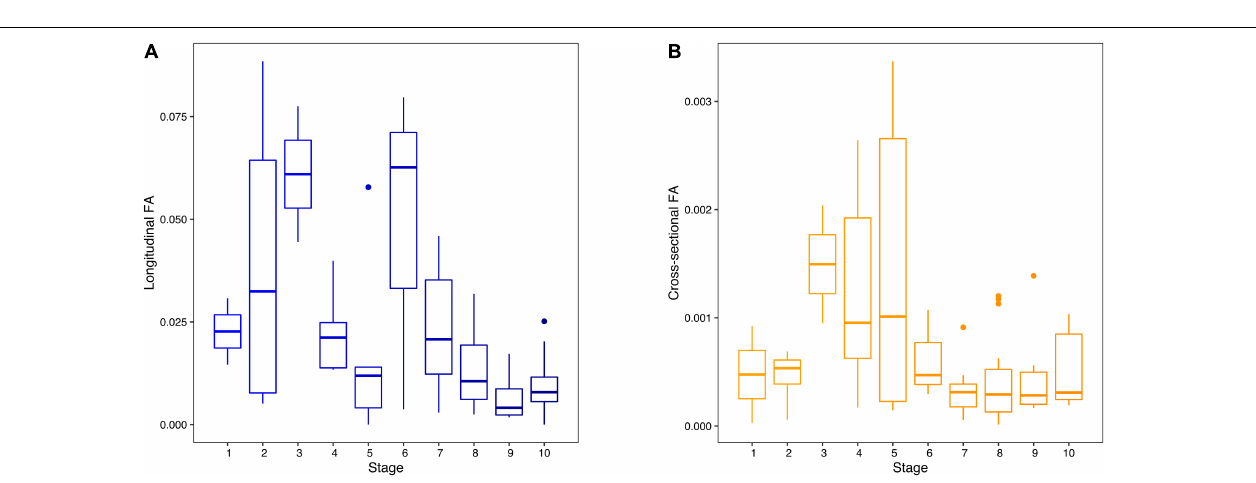
FIGURE 2 | Probability density functions of distribution of values of longitudinal (signed fluctuating asymmetry, FA) (A) and cross-sectional FA (signed FA) (B) . Bar plots show the individual asymmetry values from which density functions were estimated.